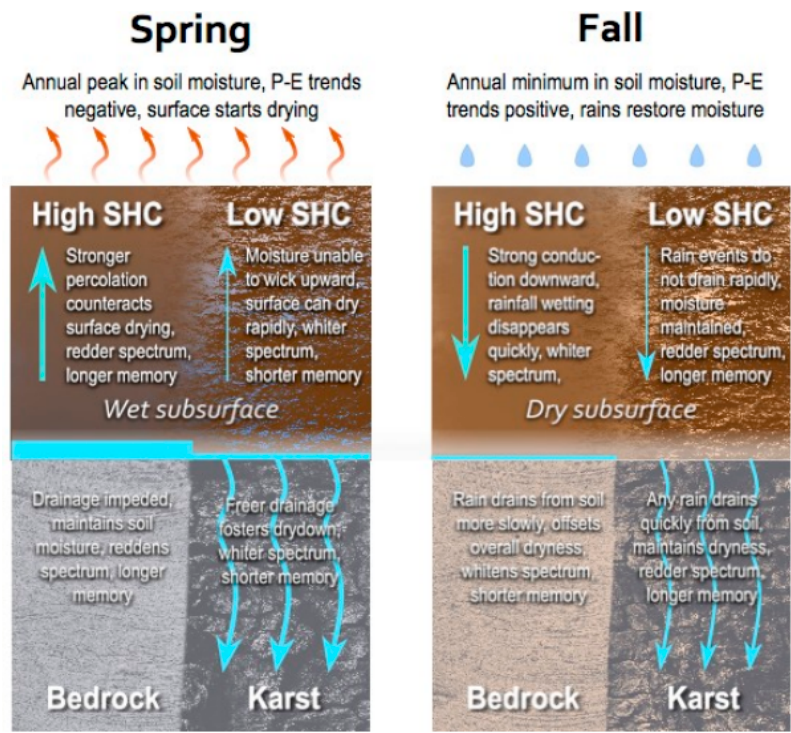
Figure 5. Effects of soil saturated hydraulic conductivity (SHC), karst and solid bedrock on the vertical movement of water, and thus surface soil moisture memory, during different times of year with contrasting spatial correlations between land properties and soil moisture memory.